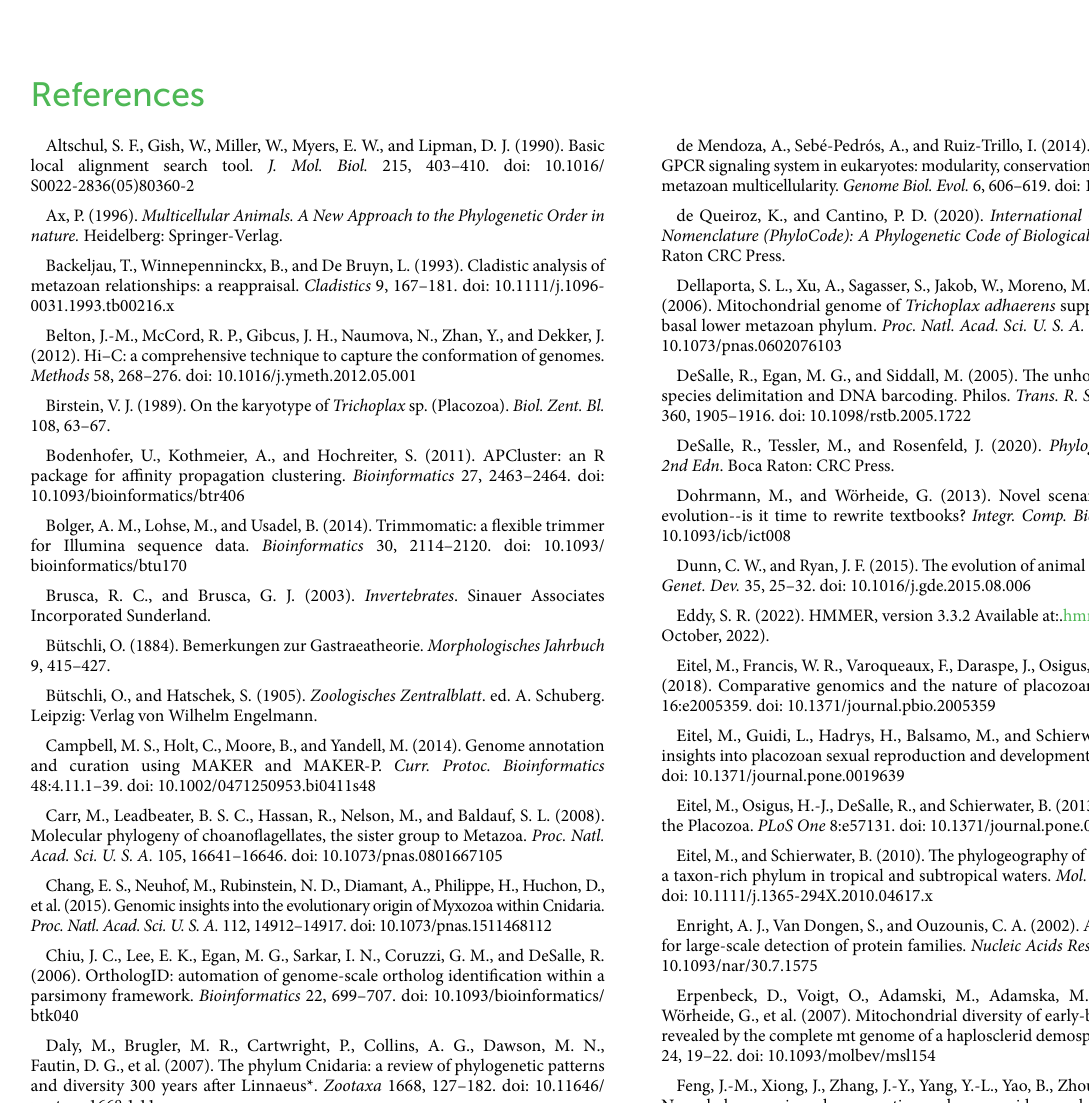
SUPPLEMENTARY FIGURE S2 Light microscopy photographs of the seven placozoan lineages currently in culture. These photos were taken under identical conditions, settings, and scale by Jonas Keunecke. In addition, we reproduce a previously published photo of H0 Polyplacotoma mediterranea , which is extinct in culture, with permission by Elsevier under license number